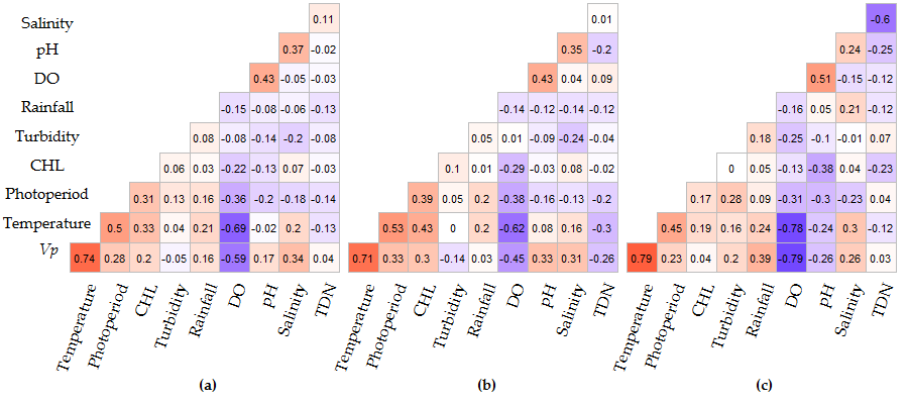
Figure 7. Spearman correlation analysis of V. parahaemolyticus concentrations and environmental variables for three intervals: ( a ) 2007 – 2016, ( b ) 2007 – 2013 and ( c ) 2014 – 2016. Red indicates positive and blue negative correlations and the degree of significance is highlighted by color intensity.